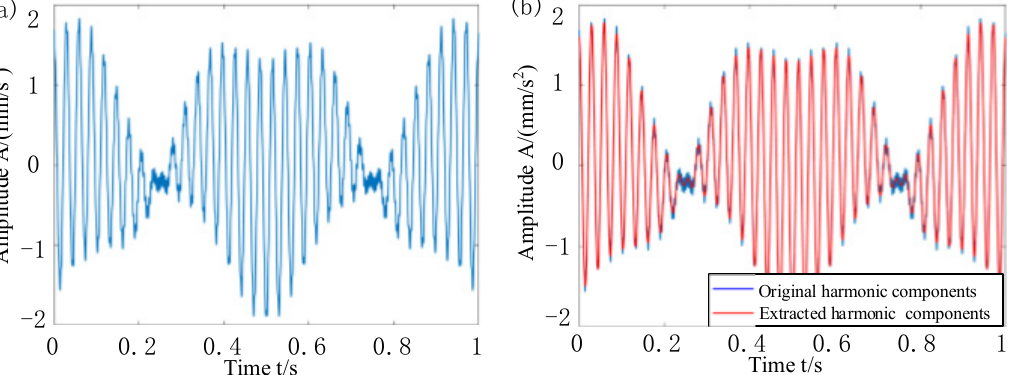
Figure 7. The adapOMP algorithm extracts harmonic components. ( a ) Adaptive extraction of the harmonic components’ time-domain waveform; ( b ) comparison of the extracted harmonic components and original harmonic components.